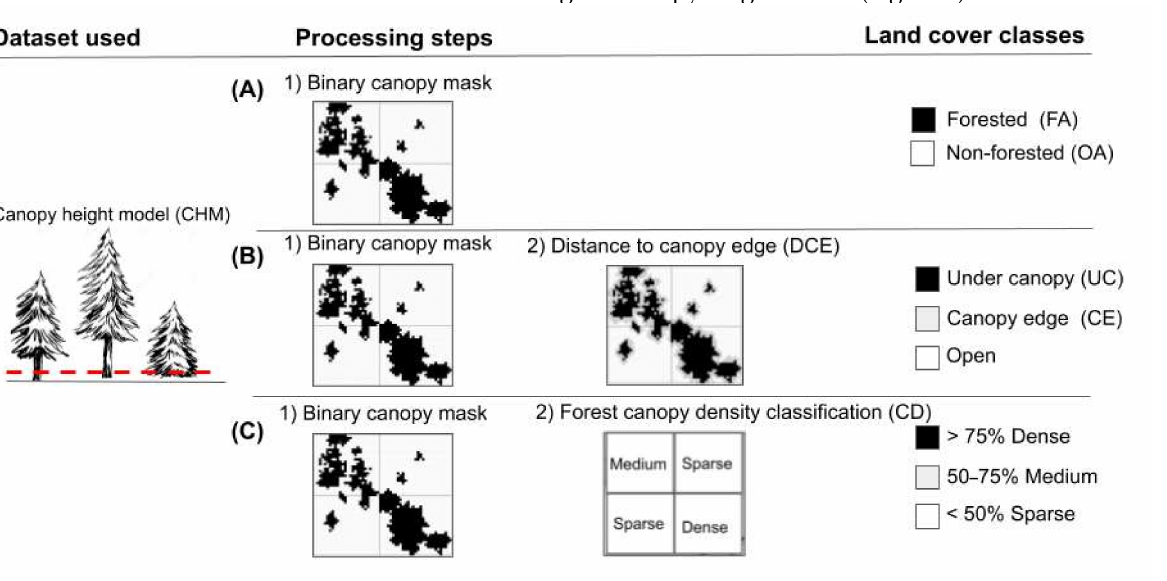
Figure 4. Framework for evaluating snow covered area mapping in forested terrain. ( A ) Classification based on canopy height; greater than 1 m (red line) is classified as forested area (FA), otherwise open area (OA). ( B ) Classification of land cover area: FA is composed of under canopy (UC) and canopy edge (CE), OA is outside CE; After Mazzotti et al., 2019 [12]. ( C ) Classification of land-cover area into forest density classes in which forest density is calculated in a larger focal pixel as a function of the vegetation presence (taller than 1 m) derived from the CHM. Forest density class is then assigned using the % of pixels. The coarse grid is 100 × 100